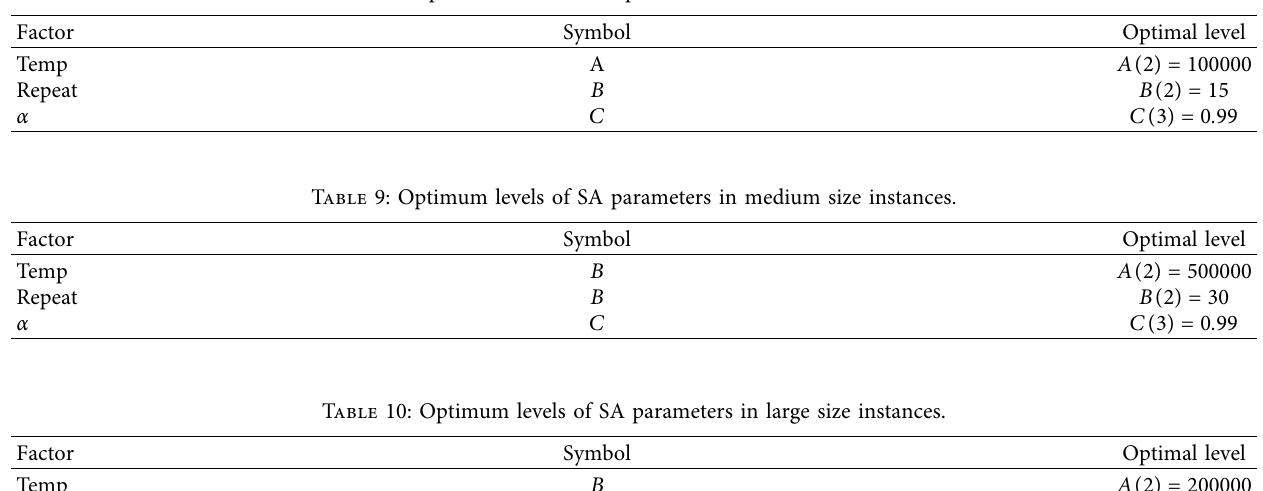
Table 8: Optimum levels of SA parameters in small size instances.